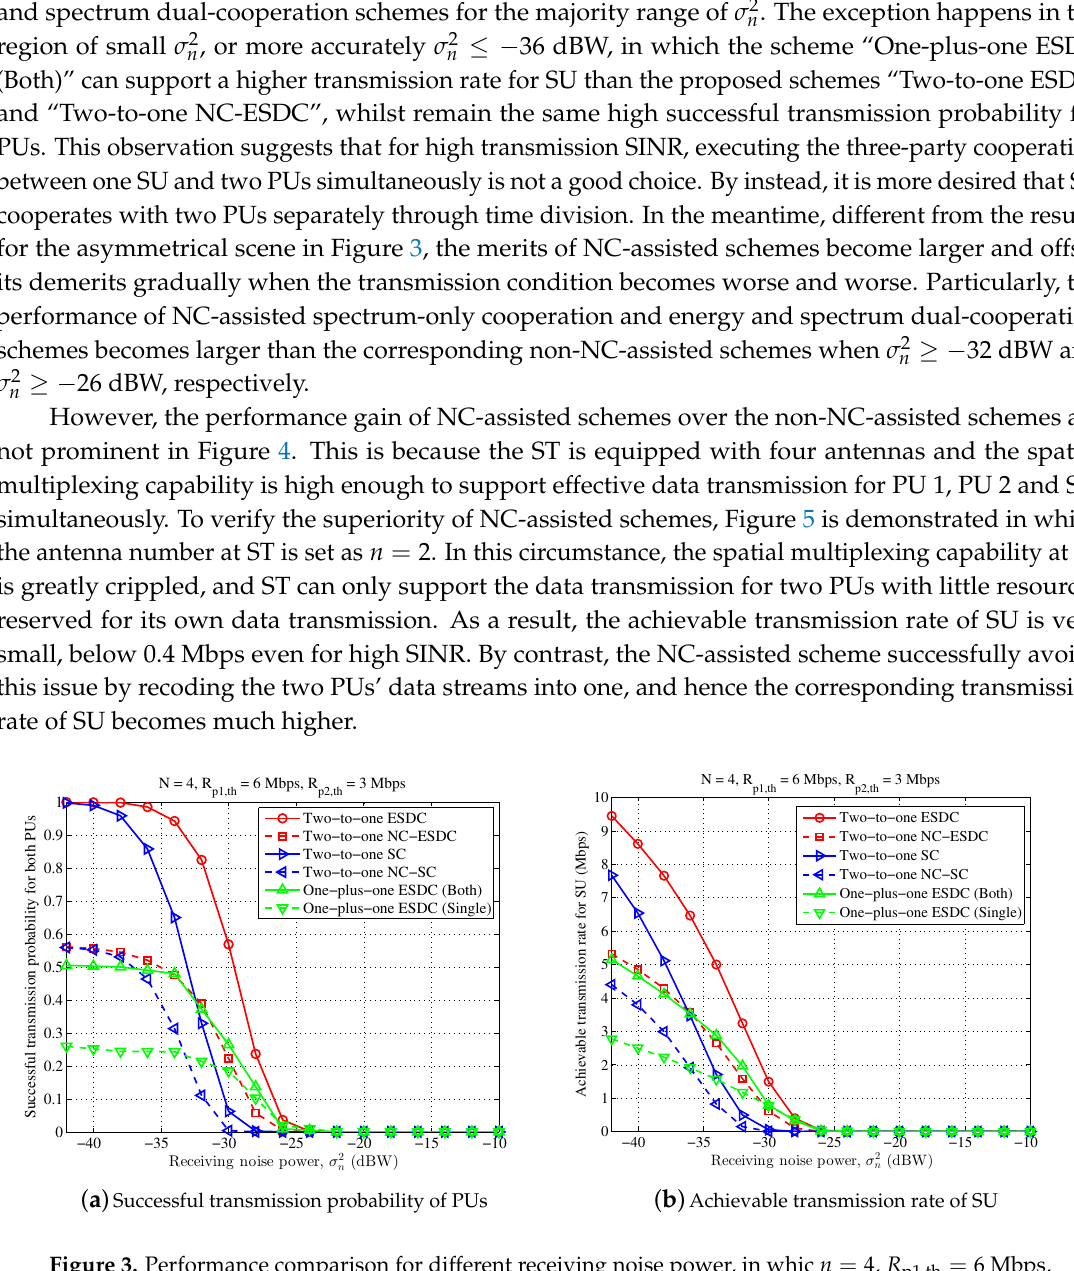
Figure 3. Performance comparison for different receiving noise power, in whic n = 4, R p1,th = 6 Mbps, R p2,th = 3